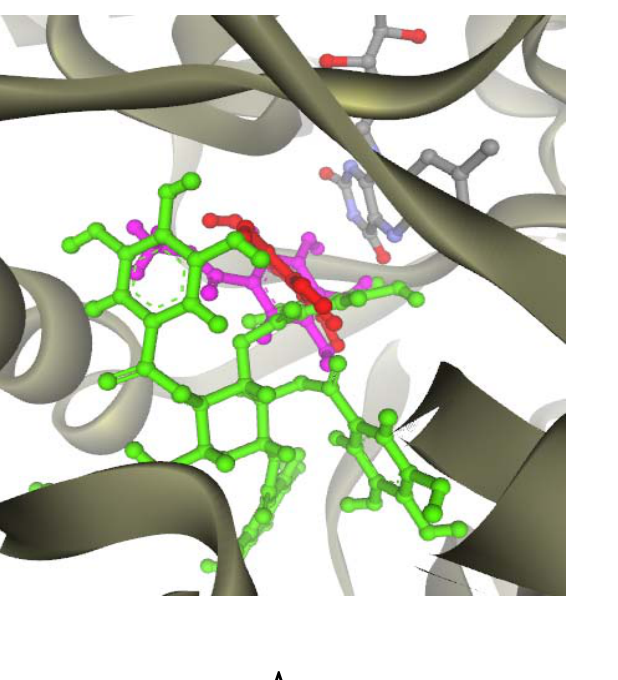
Figure 7. (A) Docked conformation of ligand structures in LAAO-CR structure (GA: Red, MG: Margenta and PGG: Green). (B–D) Distances (in Å) between residues in LAAO-CR binding pocket and ligands: GA (B), MG (C) and PGG